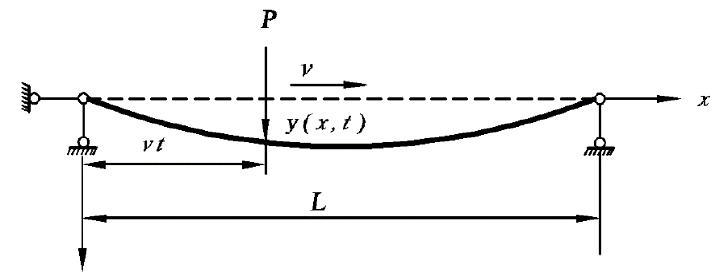
Figure 1. Simply supported beam under a moving load P at speed v . Beam length L , cross-sectional area A , moment of inertia I , elastic modulus E , shear modulus G , shear correction coefficient K and mass density ρ . 2